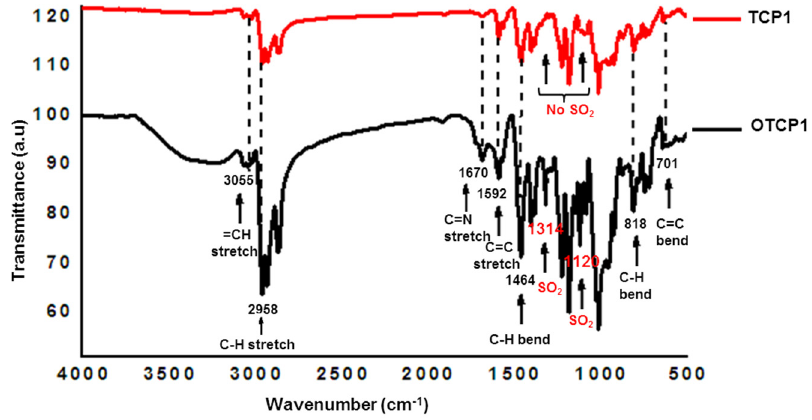
Figure 2. Comparative FTIR spectrum of TCP1 ( up ) and OTCP1 ( down ).